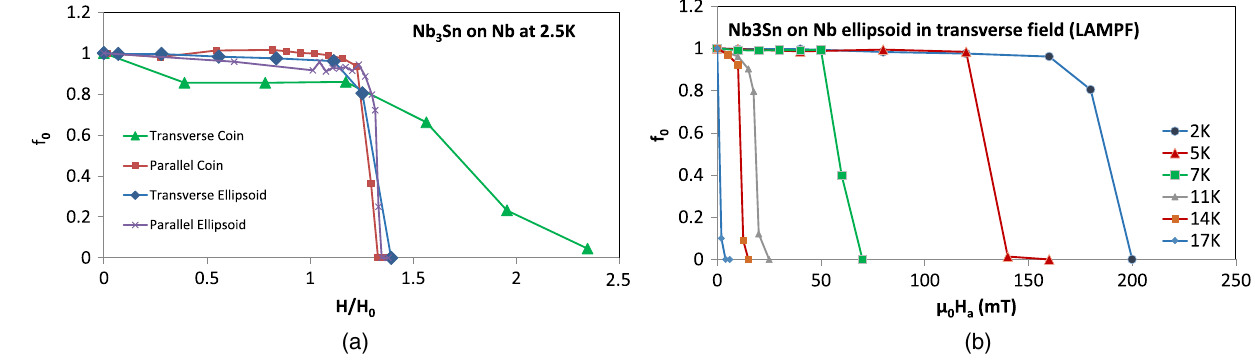
FIG. 14. Fit parameter f 0 signifying the volume fraction probed by the muons which is in the field free Meissner state as a function of applied field for 2 μ m Nb 3 Sn on Nb (a) in different geometries (b) of an ellipsoid in transverse field measured at different temperatures in the LAMPF